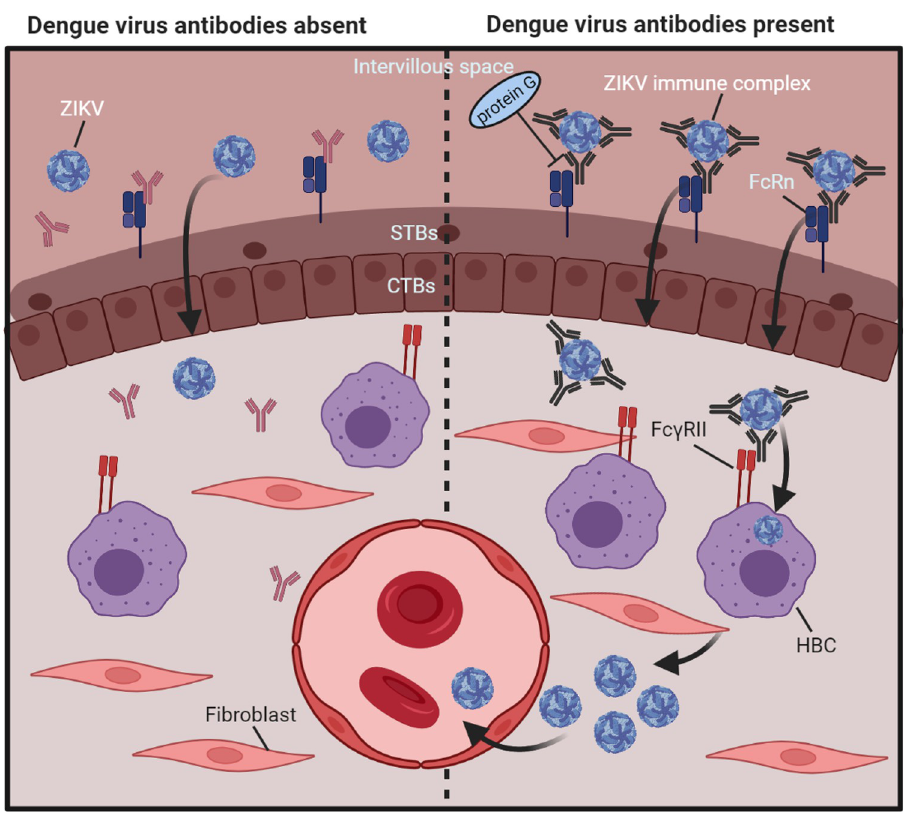
Fig 6. Proposed mechanism of ADE of ZIKV infection in the term human placenta. Left panel: In absence of cross- reactive DENV antibodies, ZIKV crosses the placental barrier less efficiently than in presence of cross-reactive flavivirus antibodies through a mechanism that is not fully elucidated yet. Right panel: In presence cross-reactive DENV antibodies, ZIKV immune complexes can be transported across the syncytiotrophoblasts layer through FcRn- mediated transcytosis. In the villus core, some non-neutralized complexes are taken up by the perivascular located HBCs through Fc γ RII, after which ZIKV can replicate in these cells. To reach the fetal circulation, ZIKV needs to subsequently cross the fetal endothelial barrier, possibly by infecting these cells. IVP; intervillous space, FcRn; neonatal Fc-receptor, STBs; syncytiotrophoblasts, CTBs; cytotrophoblasts, HBC; Hofbauer cell, Fc γ RII; Fc γ -receptor II. Created with